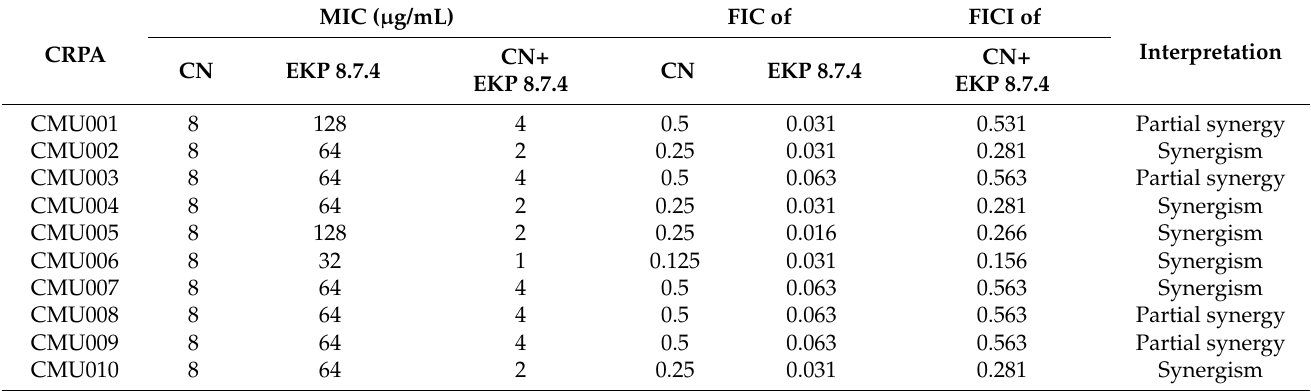
Table 7. Combination effect of gentamicin and EKP 8.7.4 extract against CRPA.